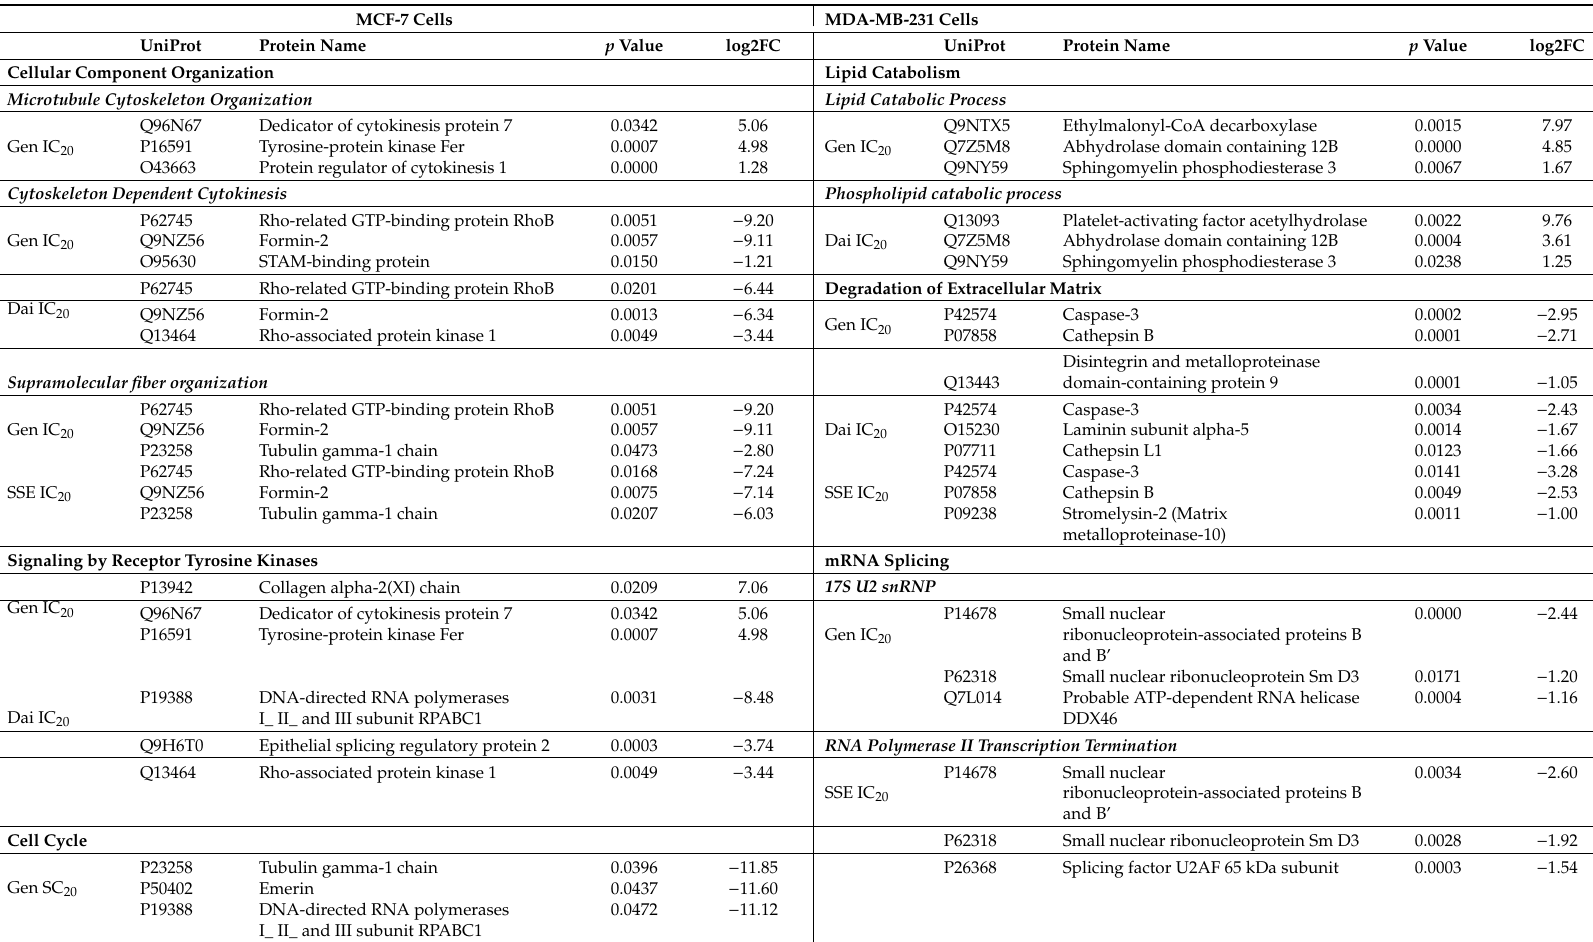
Table 2. Comprehensive view of the most altered molecular pathways, as indicated by the enrichment pathway analysis, along with the identified associated proteins following exposure of MCF-7 and MDA-MB-231 breast cancer cells to Gen, Dai and